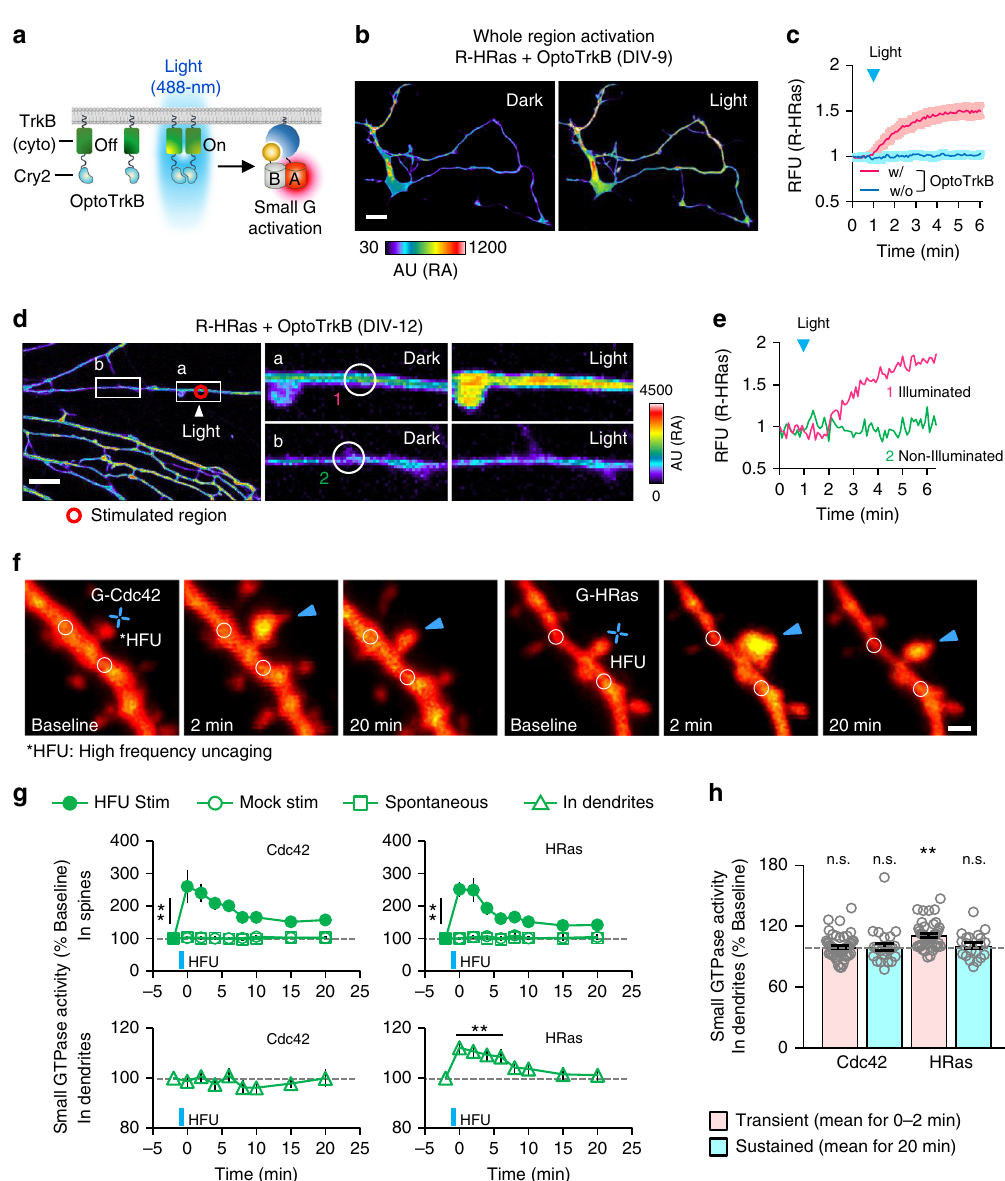
Fig. 2 Spatiotemporal visualization of small GTPase activation in dendrites and single spines upon optoTrkB activation and LTP induction. a Schematic of Ras activation by blue light-mediated OptoTrkB activation. b Cultured hippocampal neuron (DIV-9) showing fl uorescence change of R-HRas upon blue light-induced whole cell activation of OptoTrkB. Whole-cell activation; light was globally illuminated in the whole fi eld of view. c Time-lapse measurement showing fl uorescence change of R-HRas upon light stimulation. n = 4 (red), 6 (blue). Scale bar, 20 μ m. d (left) images showing local fl uorescence increase of R-HRas intensity upon OptoTrkB activation. Local stimulation was applied to a small region of dendrite (indicated by red circle) of hippocampal neuron (DIV-12) at t = 1 min. (right) Enlarged images of the indicated regions (white boxes) showing fl uorescence change of R-HRas at the region of illumination and a distal dendrite. Scale bar, 20 μ m. e Time-lapse graph showing fl uorescence changes of R-HRas within regions indicated by white circles in d (magenta; nearby stimulation, green; distal from stimulation). f Time-lapse images of dendrites from layer 2/3 pyramidal neurons co-expressing tdTomato (red) and small GTPases sensors, G-Cdc42 (left) and G-HRas (right). Target spines (arrowheads) were exposed to HFU (blue crosses). g Time-lapse measurement showing fl uorescence changes of G-Cdc42 and G-HRas in HFU-stimulated spines (top) and nearby dendrites (bottom, indicated by white circles in f , < 2.5 μ m from target spines). Filled circles, G-Cdc42: ** P < 0.01 at all post-HFU time points; n = 26 spines, 22 cells; G-HRas: ** P < 0.01 at all post-HFU time points; n = 22 spines, 19 cells. Open circles, G-Cdc42: n = 10 spines, 10 cells; G-HRas: n = 11 spines, 11 cells. Open squares, G-Cdc42: n = 23 spines, six cells; G-HRas: n = 23 spines, six cells. Triangles (G-Cdc42), n = 26 spines, 22 cells. Triangles (G-HRas), ** P < 0.01 up to 6 min; n = 22 spines, 19 cells. h Graph showing relative changes of fl uorescence of G-Cdc42 and G-HRas in dendrites in different time periods (transient and sustained) following HFU. ** P < 0.01. Statistical analysis were performed by Student ’ s two-tailed t test; n.s., not signi fi cant. *HFU: high-frequency uncaging; RFU: relative fl uorescence unit; AU: arbitrary unit; Error bars: s.e.m. Images or quanti fi ed data are representatives